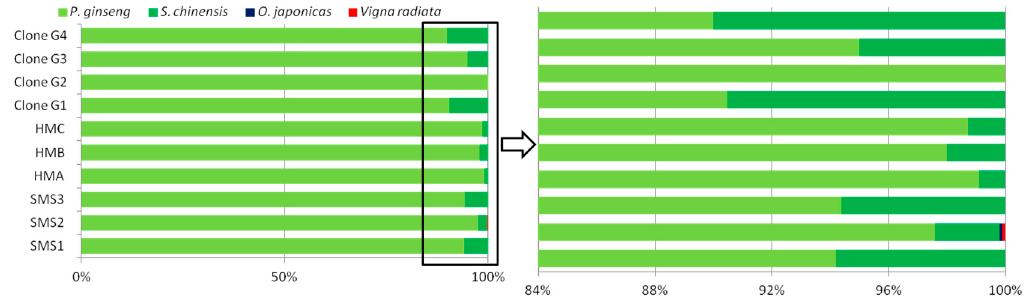
Figure 3. Percentage of different raw materials’ reads in ITS2 (the second internal transcribed spacer of nuclear ribosomal DNA) amplicons of SMS. HMA/B/C and SMS1/2/3 were analyzed by FLMB, while Clone G1/G2/G3/G4 were analyzed by clone-dependent Sanger sequencing.